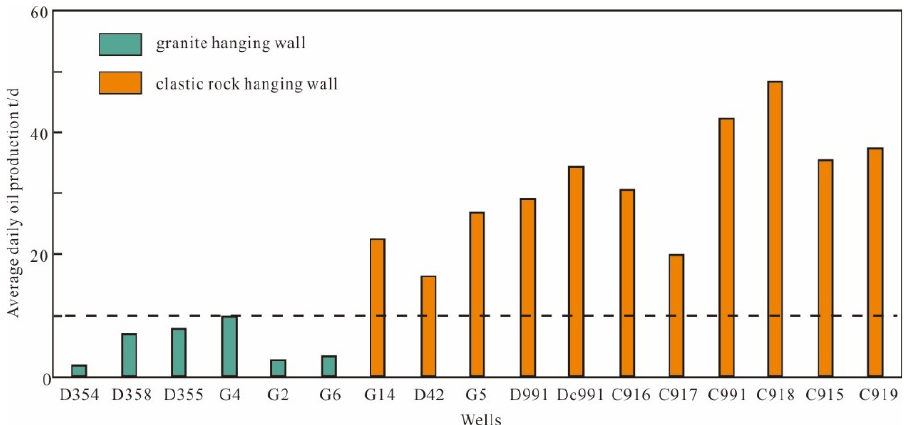
Figure 10. The relationship between oil production and lithology of hanging wall.